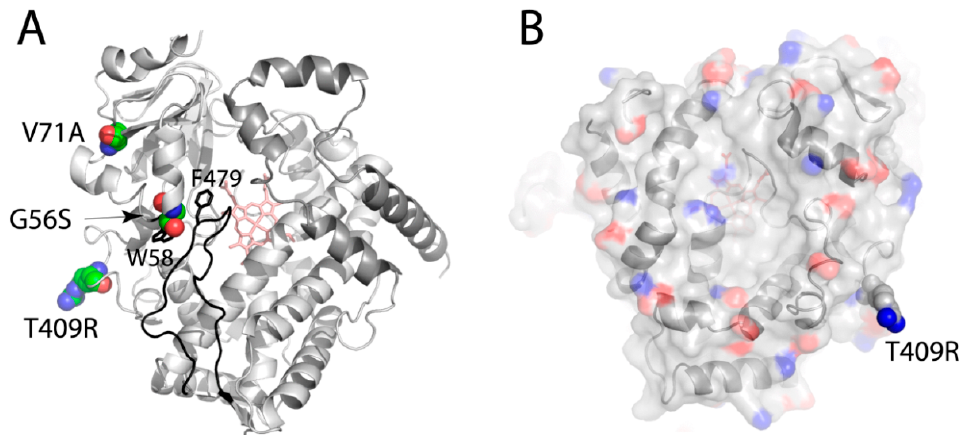
Figure 11. Naturally occurring CYP3A7 mutations. ( A ) Distal view showing location of mutated residues (in cpk representation). The C-terminal loop is rendered in black. Side chains of W58 and F479 are displayed to demonstrate steric clashing with S56. ( B ) Charge distribution on the proximal surface of CYP3A7. Positively and negatively charged groups are in blue and red, respectively. The T409R mutation introduces an additional positive charge, which could assist docking of the redox partner, cytochrome P450 reductase.